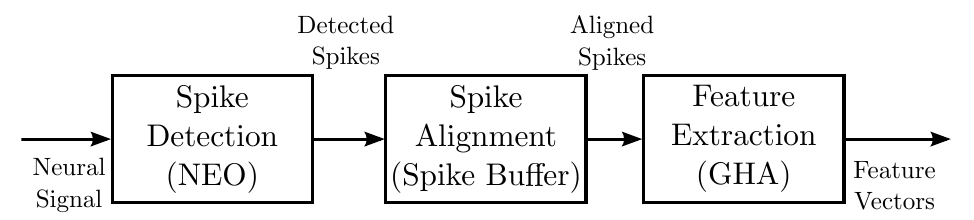
Figure 1. The general block diagram of the proposed architecture for spike